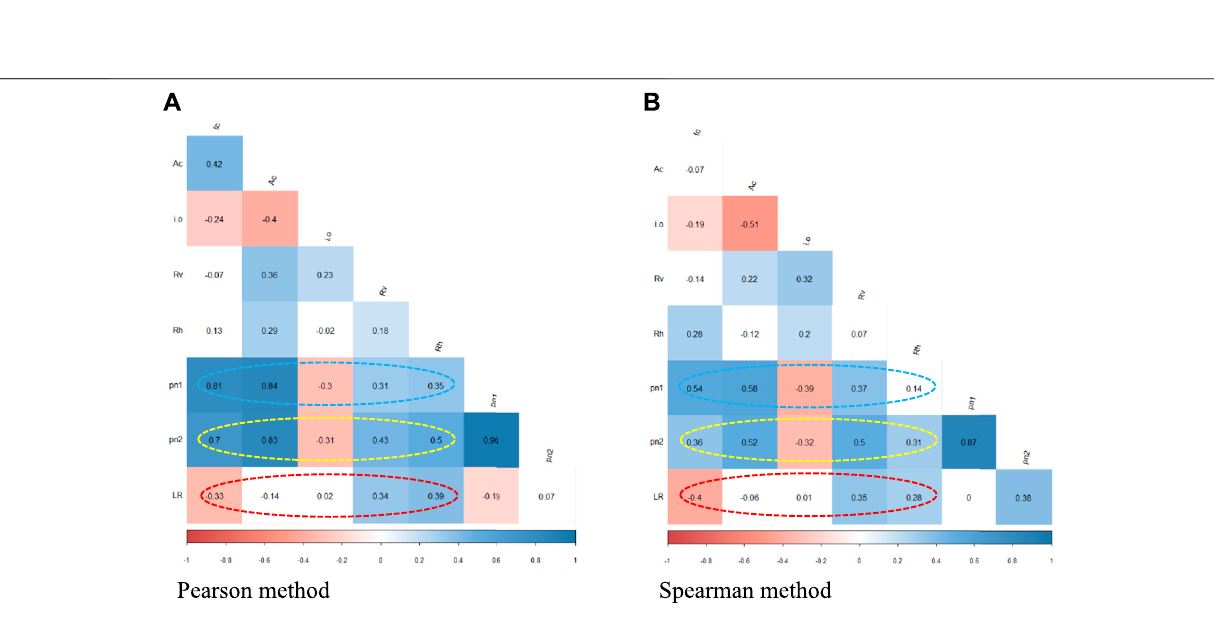
Frontiers in Materials |